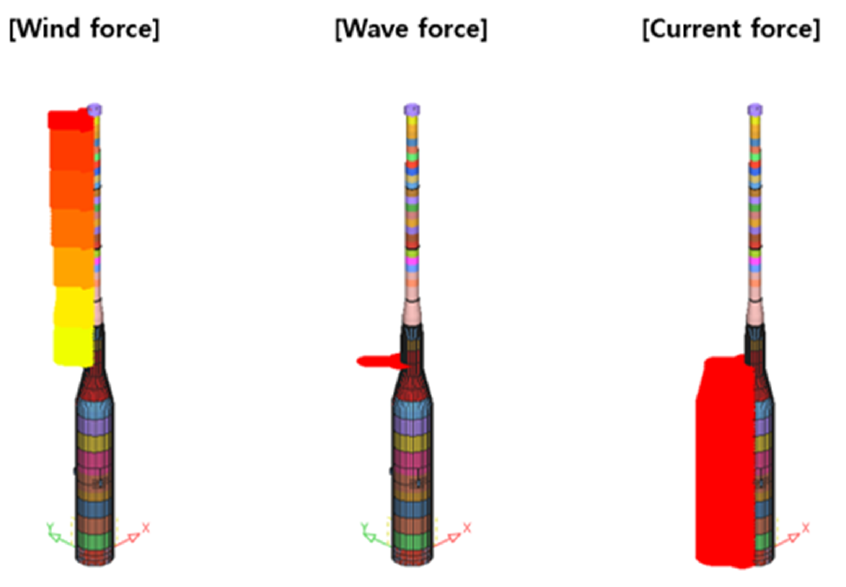
Figure 13. Visual representation of environmental loads (wind force, wave force, and current force).